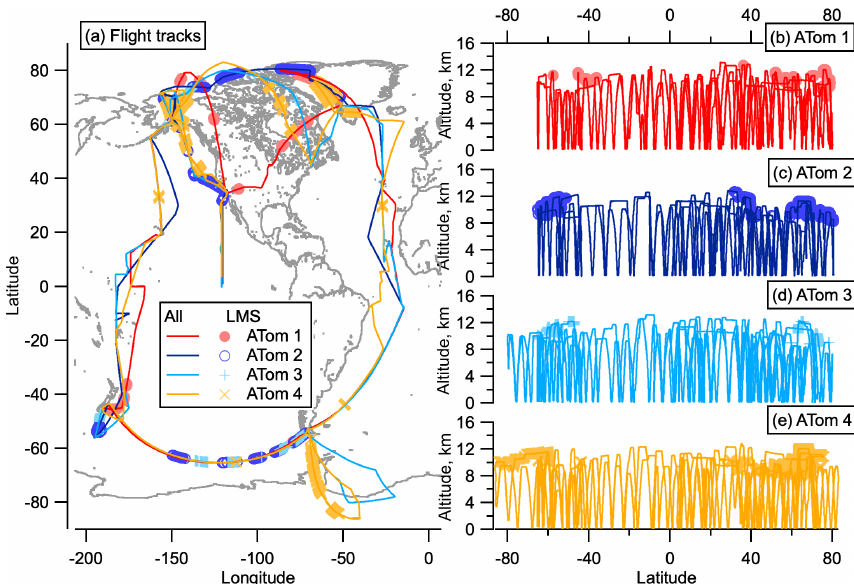
Figure 1. ATom flight locations. Flight tracks from ATom in all four seasons as a function of latitude and longitude (a) and altitude and lati- tude (b–e) . Sampling in the LMS (O 3 > 250ppbv and relative humidity over water (RH w ) < 10%) is highlighted in light-coloured symbols. The world map was made with Natural Earth free vector and raster map data, http://www.naturalearthdata.com (last access: 10 December